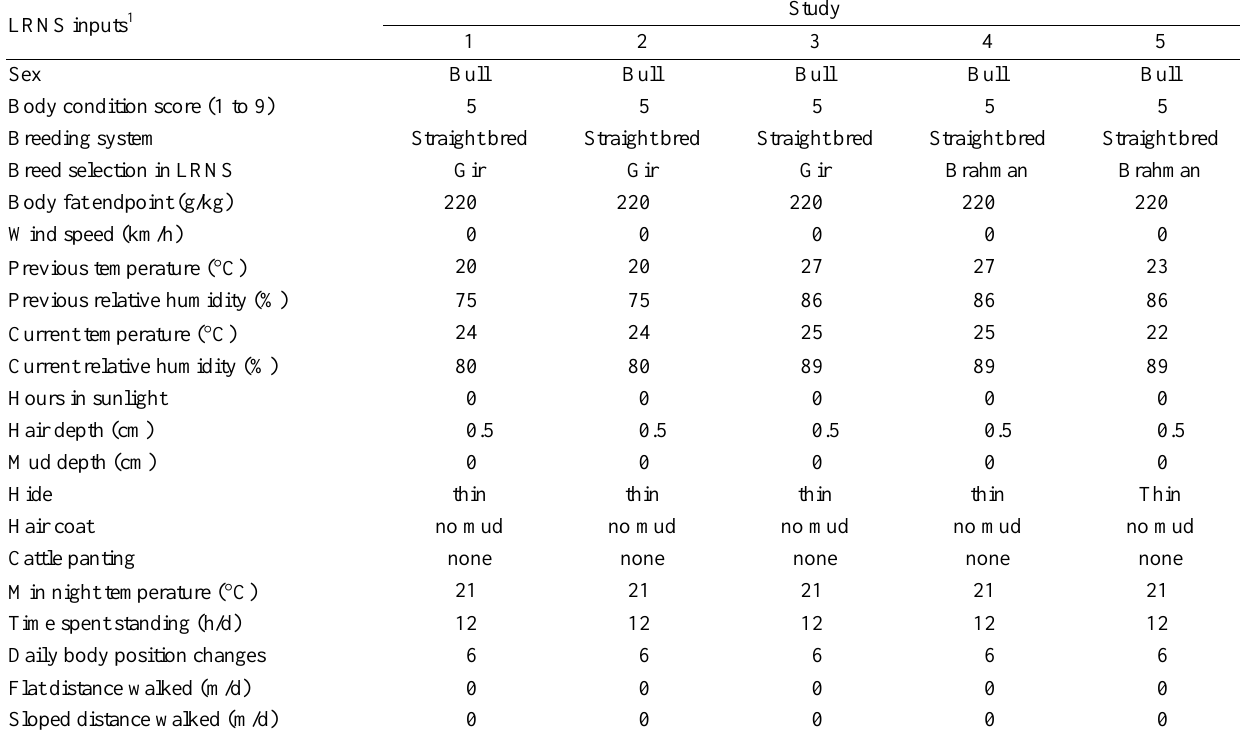
Table 3. Input variables and their values used to simulate five studies used to evaluate the large ruminant nutrition system (LRNS)